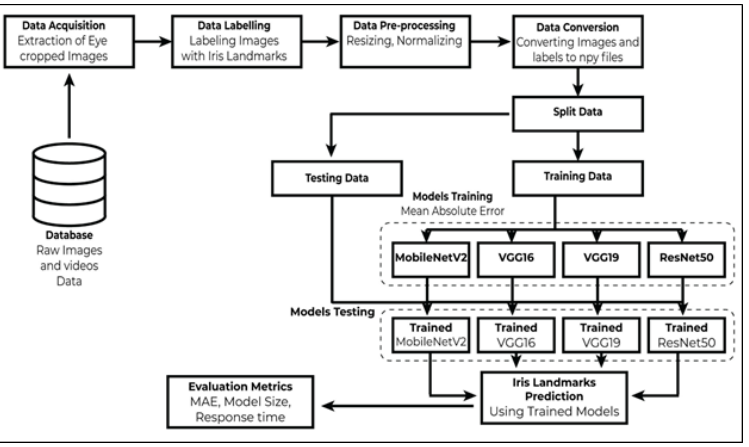
Figure 4. Training and testing procedure of proposed